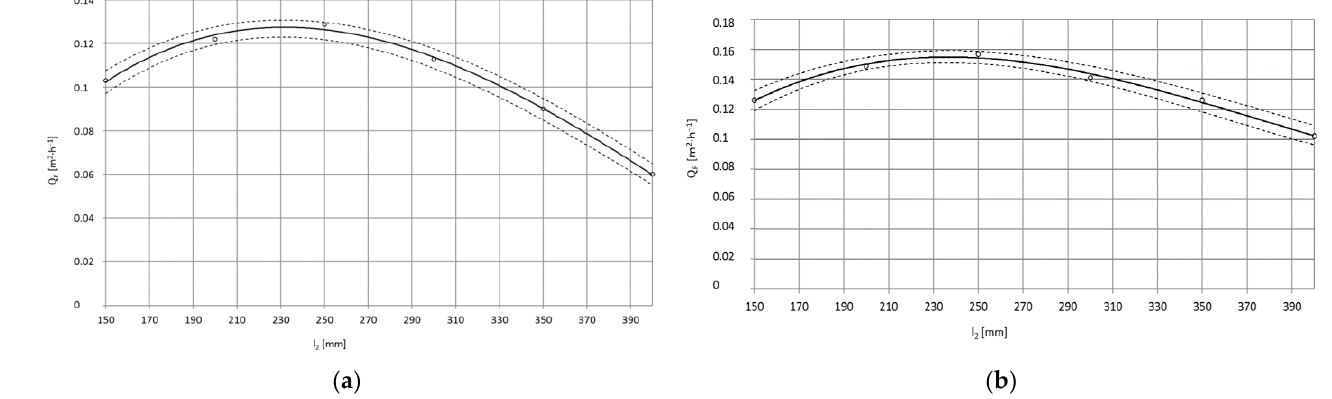
Figure 13. Influence of jet working length l 2 [mm] on maximum surface efficiency Q F [m 2 · h − 1 ] of coat paint stripping with high-pressure water-ice jet from X5CrNi18-10 steel surface (TS = 4 × 1.2 mm, L k = 200 mm, κ = 90 ◦ , m L = 156 kg · h − 1 ): ( a ) Jet pressure p w = 20 MPa; ( b ) p w = 35 MPa.